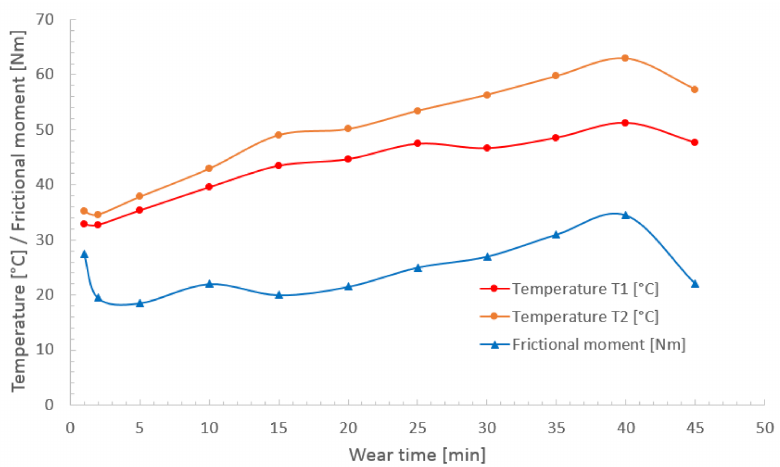
Figure 11. Frictional moment and temperatures T1 and T2 as function of wear time for specimen laser borided with laser beam scanning velocity v l = 50 m / min and initial boron layer t b = 100 µ